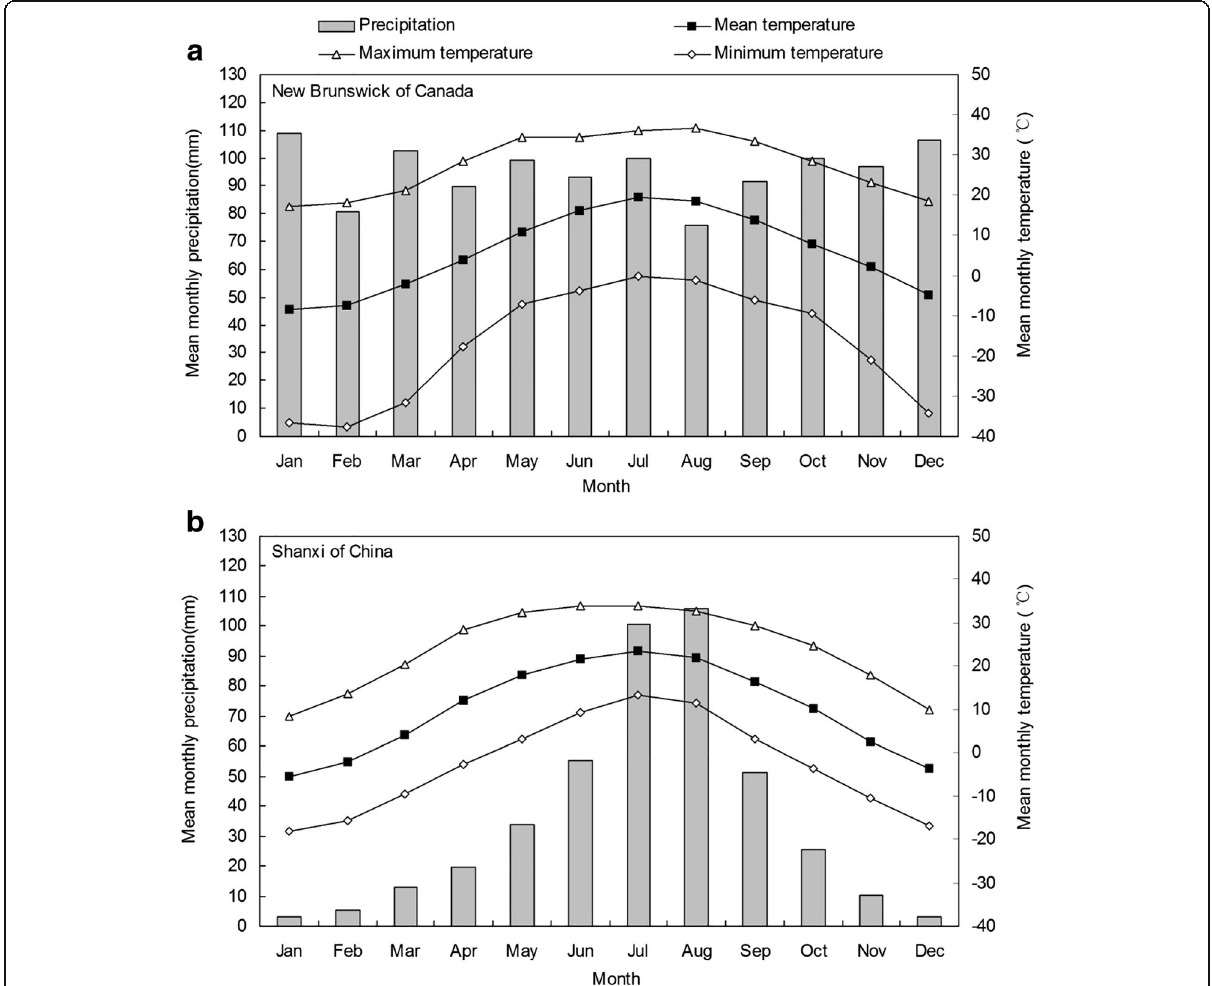
Fig. 2 Mean monthly precipitation and temperature (mean, maximum and minimum) of seed origins from 1971 to 2000. Eastern larch and paper birch are from NB (New Brunswick), eastern Canada ( a ); Prince Rupprecht ’ s larch and white birch are from Shanxi, northern China ( b